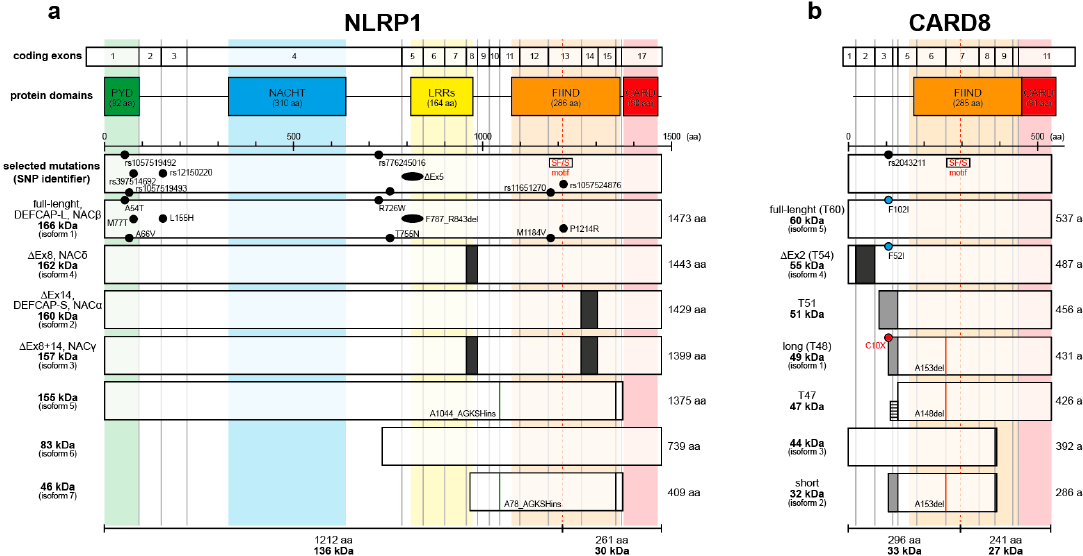
Figure 1. Isoforms of human NLRP1 and CARD8. ( a ) Full-length NLRP1 consists of five domains, an aminoterminal pyrin domain (PYD), a NACHT domain (NACHT), a leucine-rich repeats domain (LRRs), a function-to-find domain (FIIND), and a carboxyterminal caspase activation and recruitment domain (CARD). Self-processing occurs at S1213 in the SF/S motif of the FIIND. NLRP1 is encoded by up to 17 exons. Exon 8 is missing in isoform 4 (NAC δ ) and isoform 3 (NAC γ ) whereas exon 14 is missing in isoform 2 (DEFCAP-S, NAC α ) and isoform 3 (NAC γ ). Isoform 5 and 7 have 4 amino acids (GKSH) insertion after A1044 or A78, respectively. Selected NLRP1 mutations in human disease with skin involvement are depicted (for more information refer to Table 1). ( b ) CARD8 contains two domains, a FIIND and a CARD, with a variable aminoterminus and is encoded by up to 11 exons. T54 isoform misses exon 2 whereas isoform 1 (T48), isoform 2 (short), and T51 have alternative splicing replacing exons 1-3. CARD8 short, long and T47 have a deletion at A153 and A148, respectively. The SNP rs2043211 causes mutations in T60, T54, and T48, introducing in the latter a stop codon. Alternative splicing with translation of part of an intron generates a T47 isoform, which misses the nonsense mutation found in T48. Most of the variants of NLRP1 and CARD8 are poorly characterized. Table 1. Selected NLRP1 mutations in human disease with skin involvement.